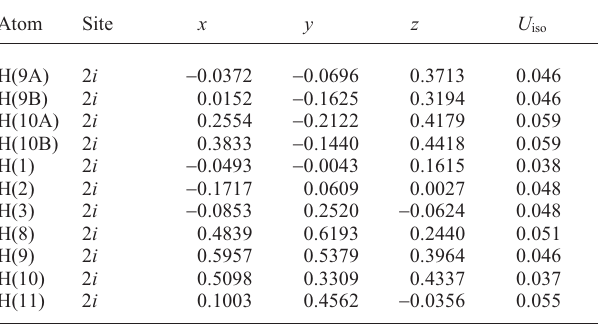
Table 2. Atomic coordinates and displacement parameters (in Å 2 )